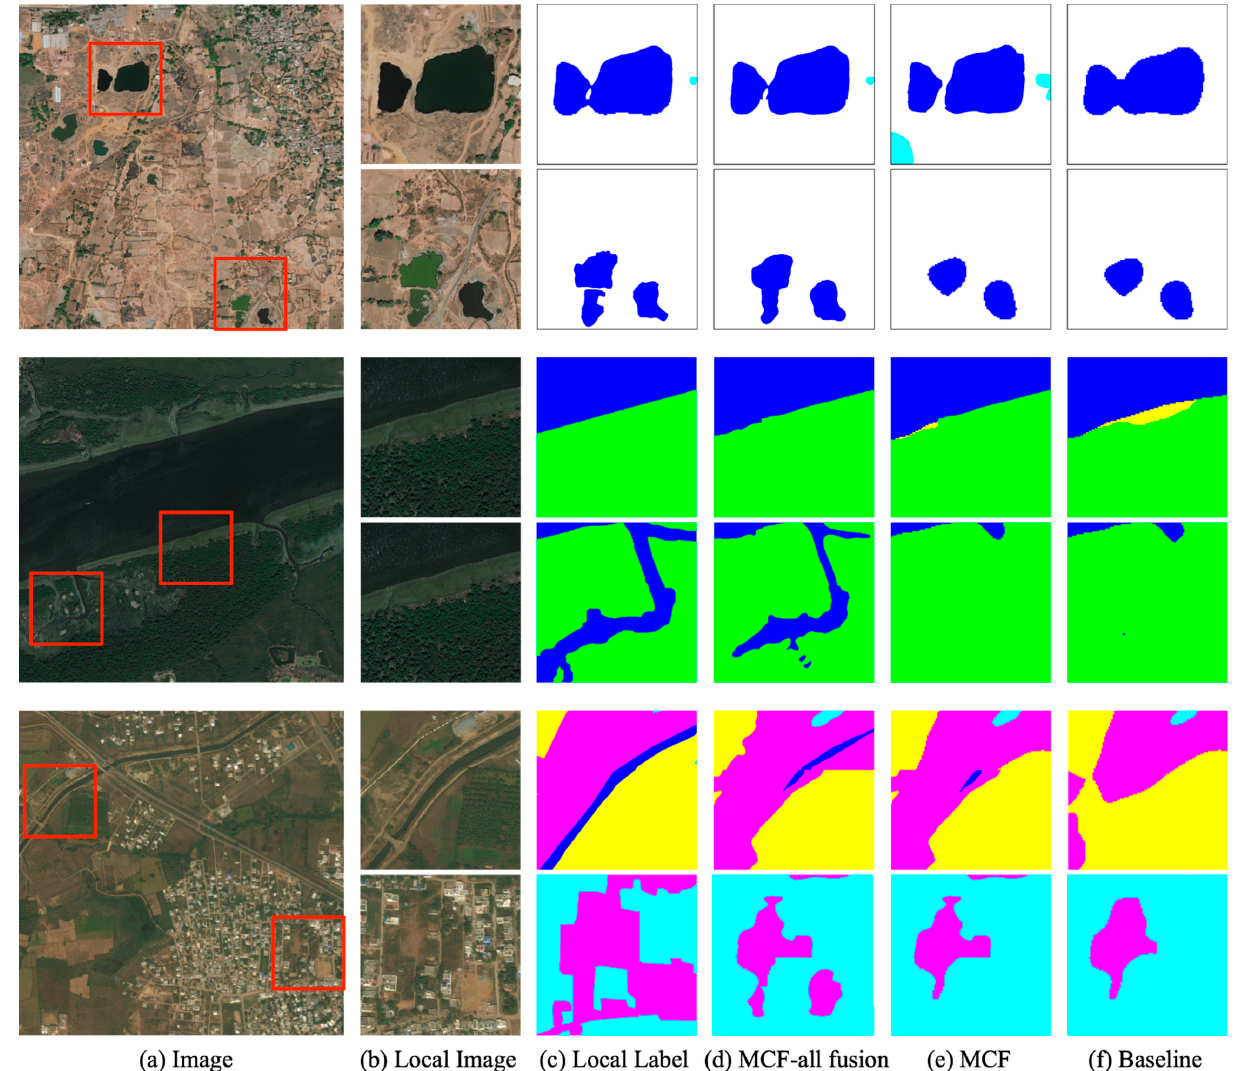
Figure 11. Local details of the DeepGlobe image through different methods. Table 6. The effects of different components of our method on the results.